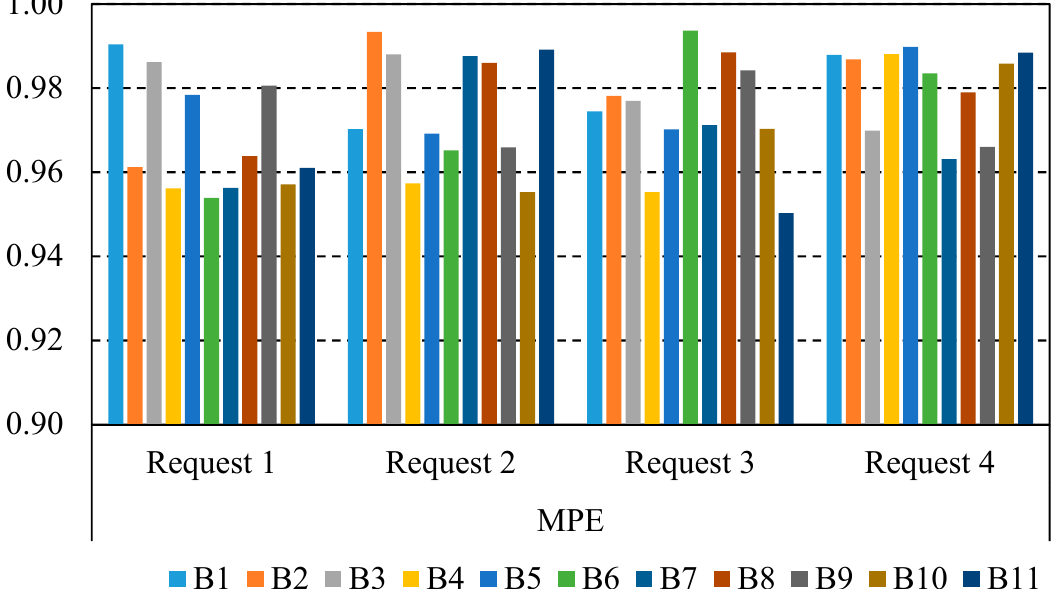
Figure 8. The MPE performance indicator in the East Aghili Canal. Water 2020 , 12 , x FOR PEER REVIEW 0.02.04.06.08.010.012.0